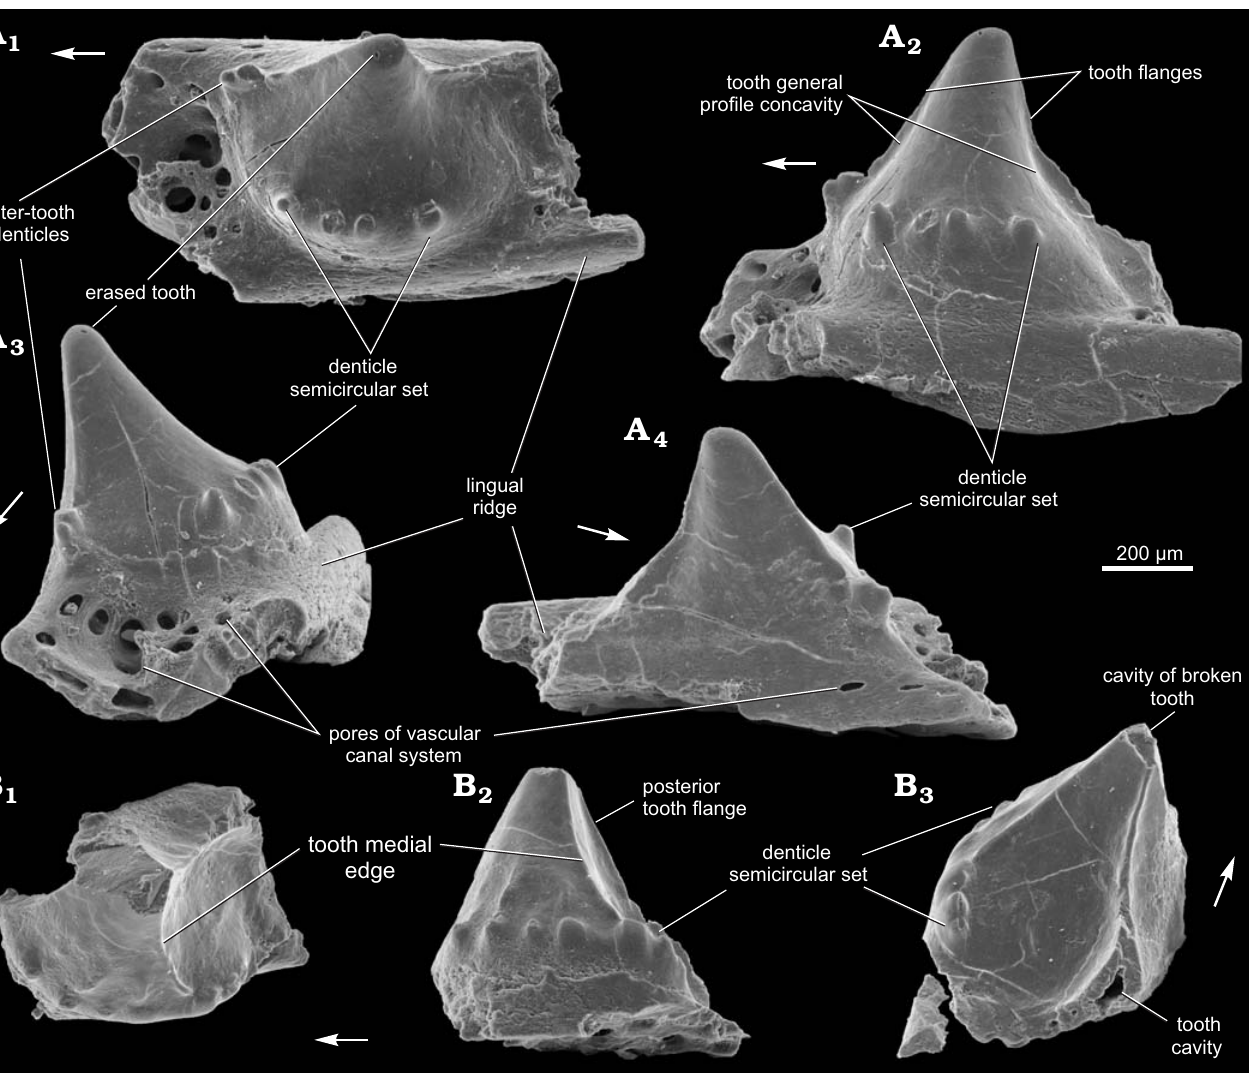
Fig. 4. Ischnacanthiform fish Drygantacanthus semirotunda gen. et sp. nov., Dniester River, north-west Zalishchyky outskirts, Podolia, Ukraine, Upper Lochkovian, Ivanie Horizon; the paratypes, SMNH BP.1587/3 ( A ) and SMNH BP.1590/11 ( B ). Jaw bone fragments in occlusal (A 1 , B 1 ), lingual (A 2 , B 2 ), anterior (A 3 ), lateral (A 4 ), and posterior (B 3 ) views. Arrows indicate rostral